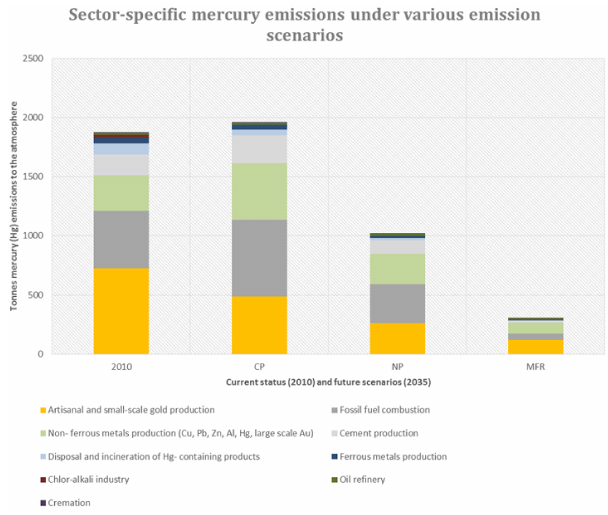
Figure 2. Sector specific emissions of mercury under various emis- sion scenarios in